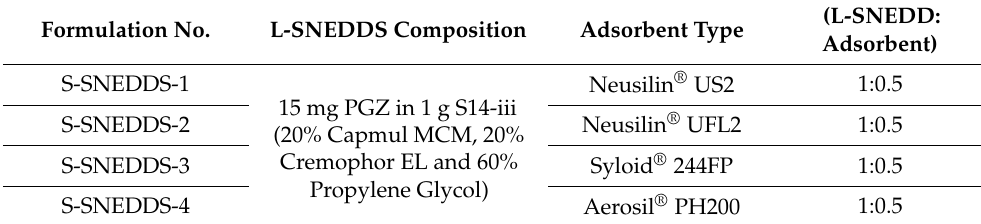
Table 5. Components of solidified PGZ SNEDDS (S-SNEDDS) formulations using different adsor- bent